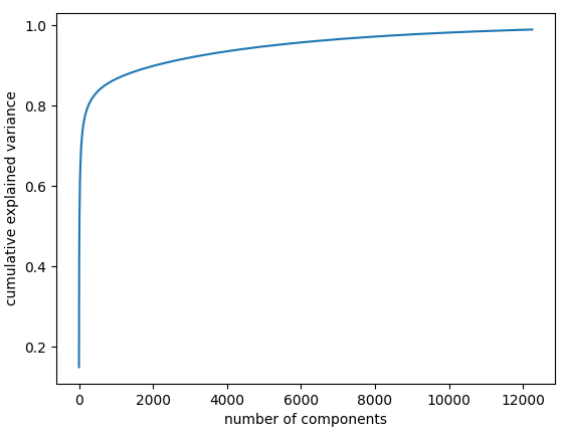
Figure 3. Cumulative explained variance: 99% of the data are represented with 12,000 components.